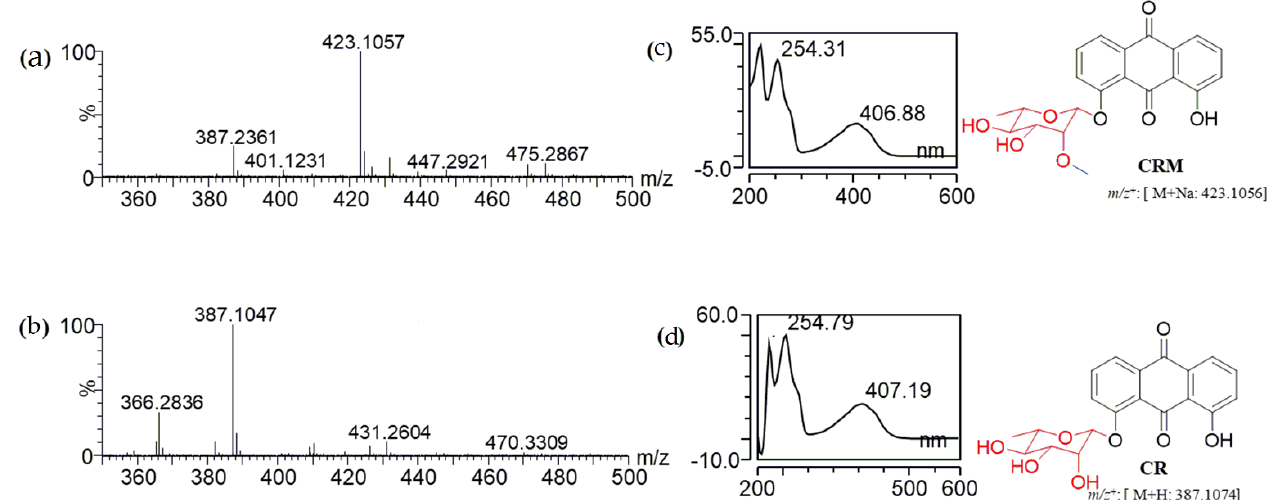
Table 1. Comparison of 1 H- and 13 C-NMR chemical shifts of chrysazin, chrysazin-8-O- α - L -rhamno-